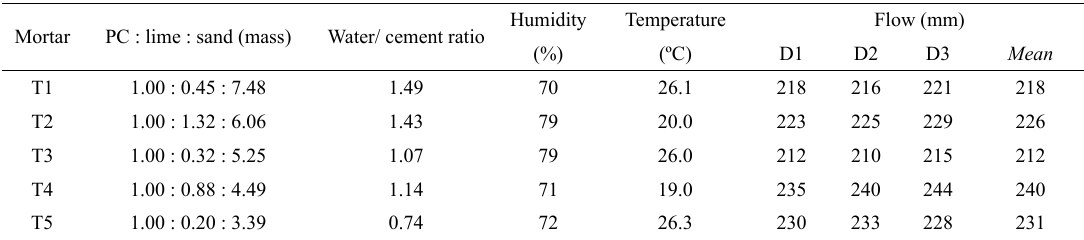
Table 4. Mortar compositions and environmental conditions during its production.